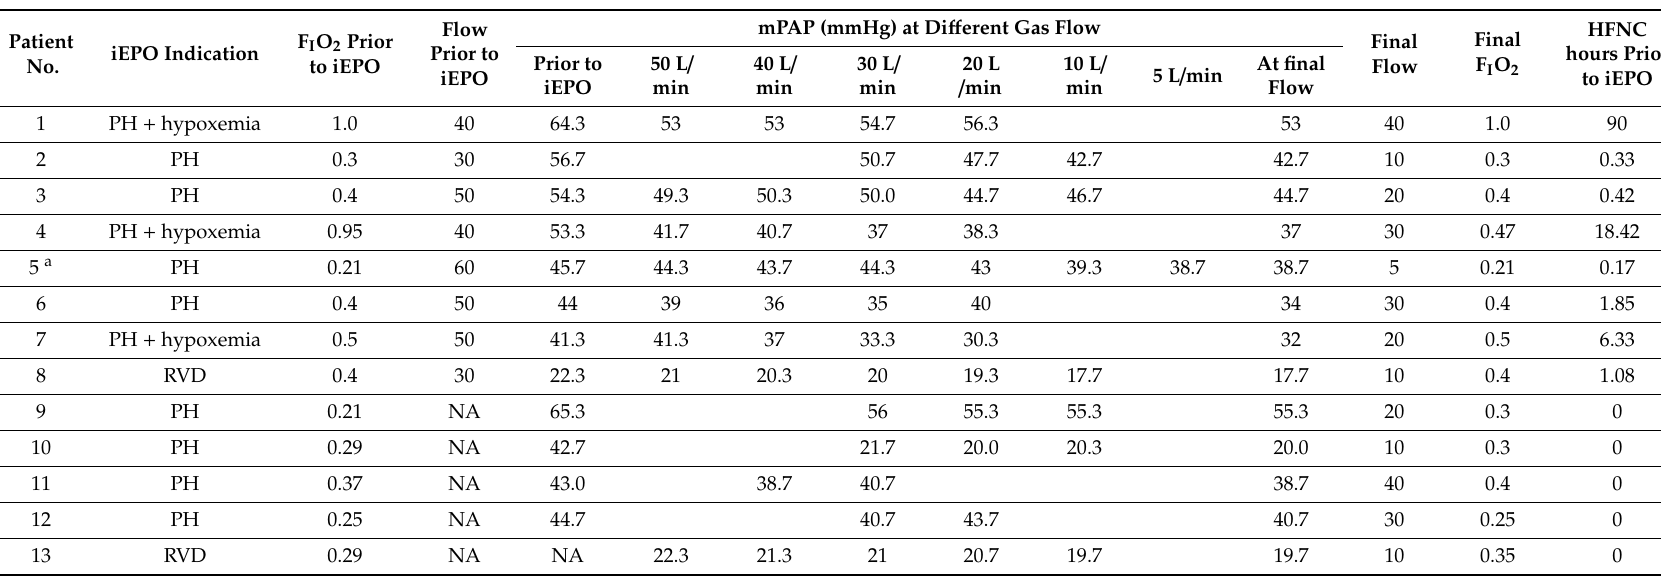
Table 2. Individual patient’s mPAP changes to di ff erent HFNC gas flows in the flow titration group of patients who had invasive hemodynamic monitoring. Patient